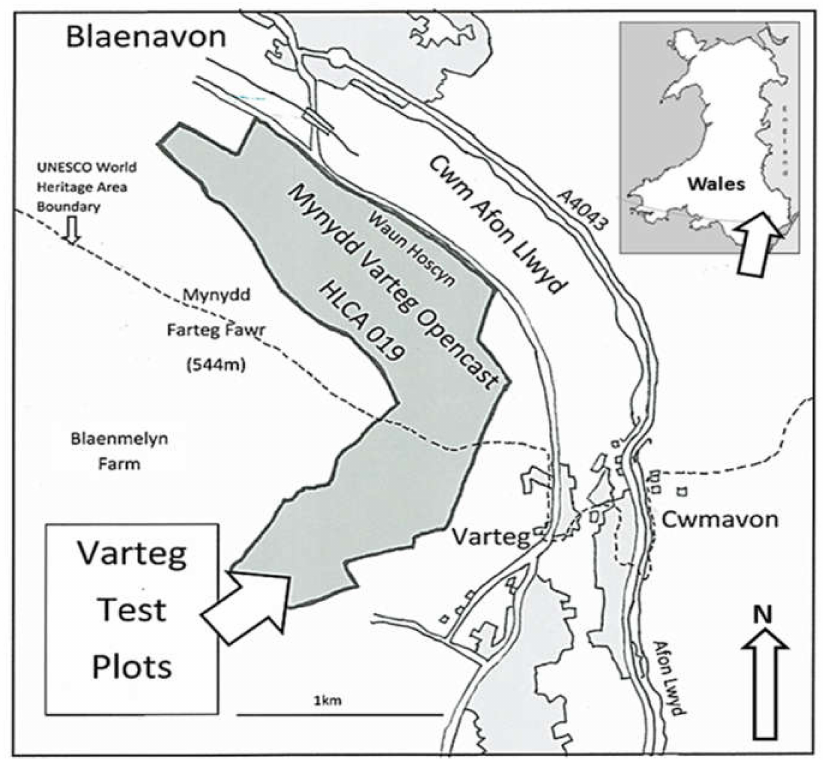
Figure 1. Location of the Varteg test plots, south of the UNESCO Blaenavon Industrial Landscape World Heritage Area, SE Wales.